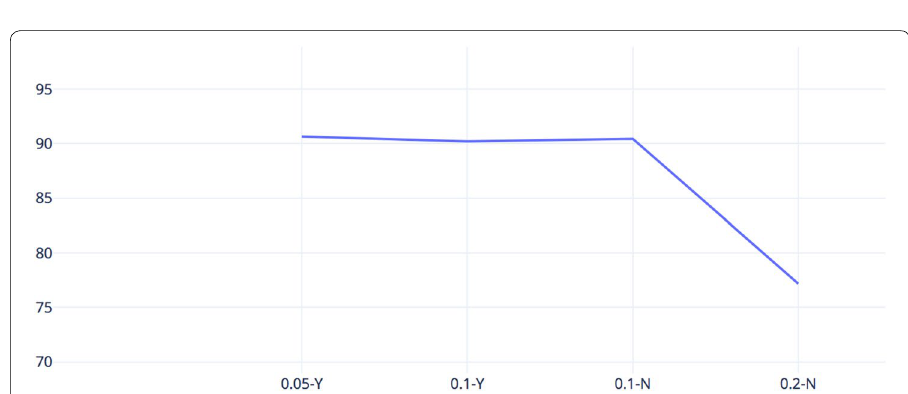
Fig. 7 Comparison of various NB and DF configurations—precision